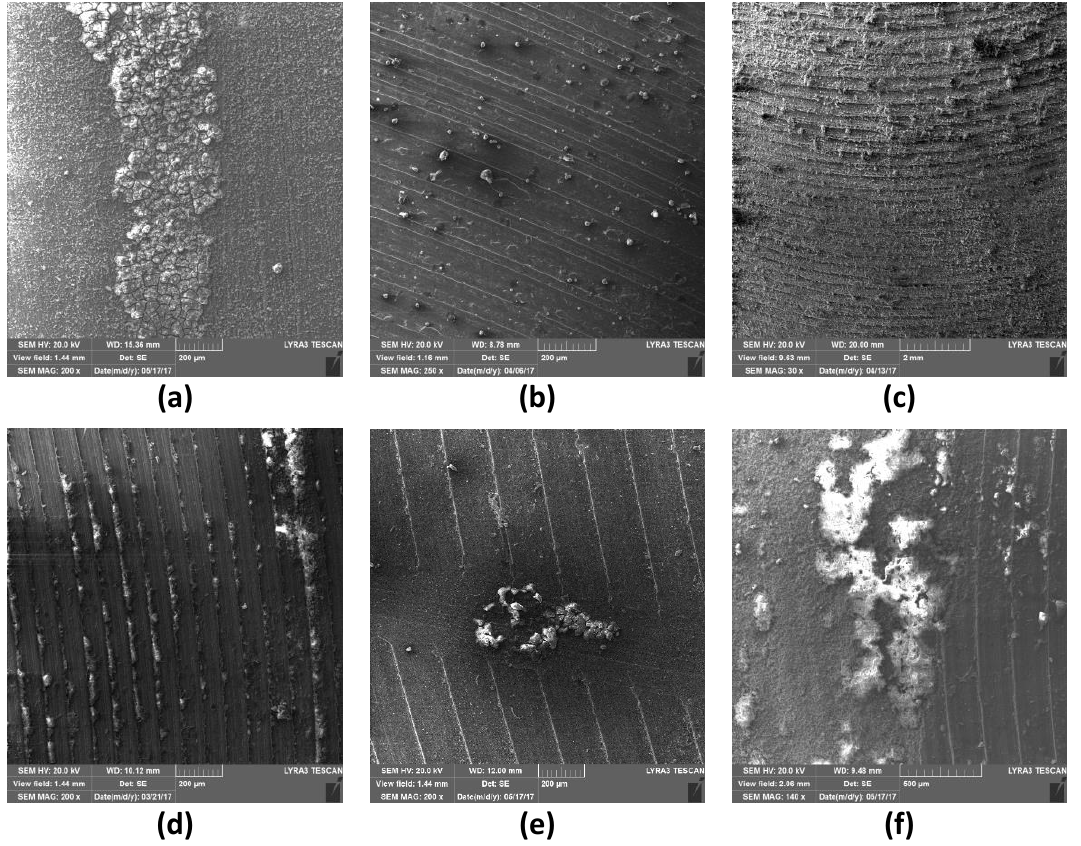
Figure 11. SEM images of corroded surfaces of ( a ) unprocessed Al, ( b ) FH-1, ( c ) FL-1, ( d ) FM-1, ( e ) FM-2, and ( f ) FM-3 after 21 days of immersion.